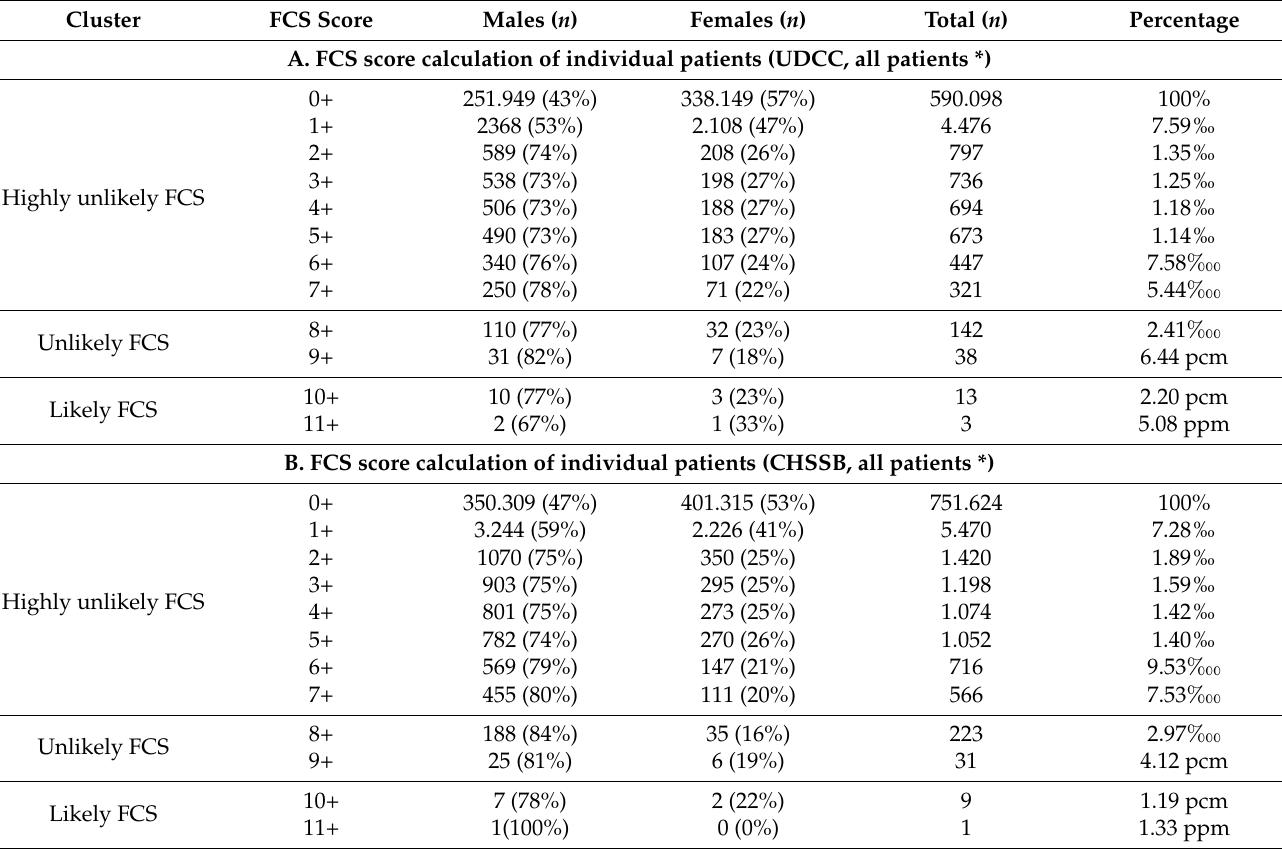
Table 5. Familial chylomicronemia (FCS) score calculation of individual